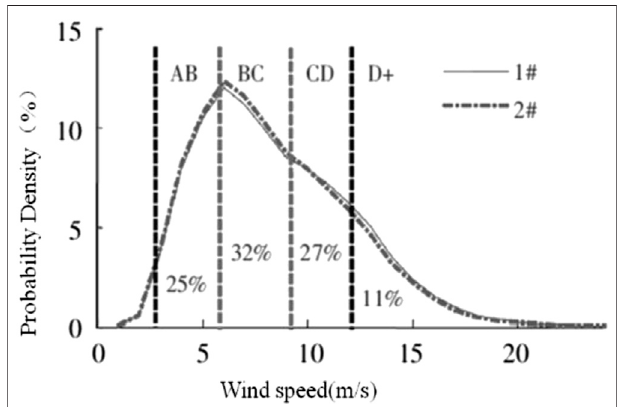
FIGURE 9 | Wind speed probability distribution curve.